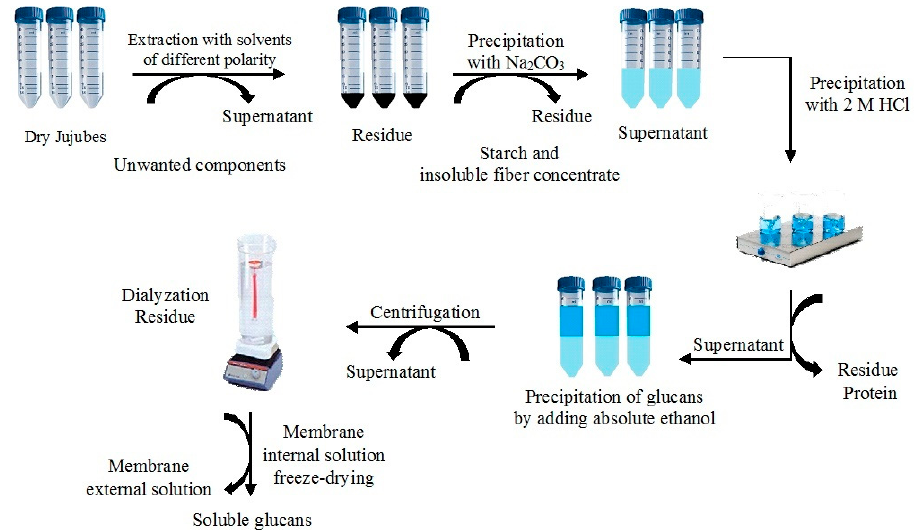
Figure 1. Scheme of the extraction of crude and soluble glucans.